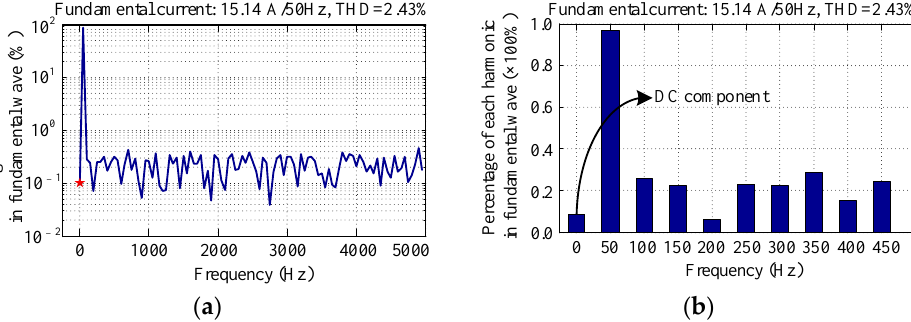
Figure 9. Fourier analysis of i a when the proposed NPV control strategy is adopted. ( a ) Harmonic analysis; ( b ) low-frequency harmonics analysis.